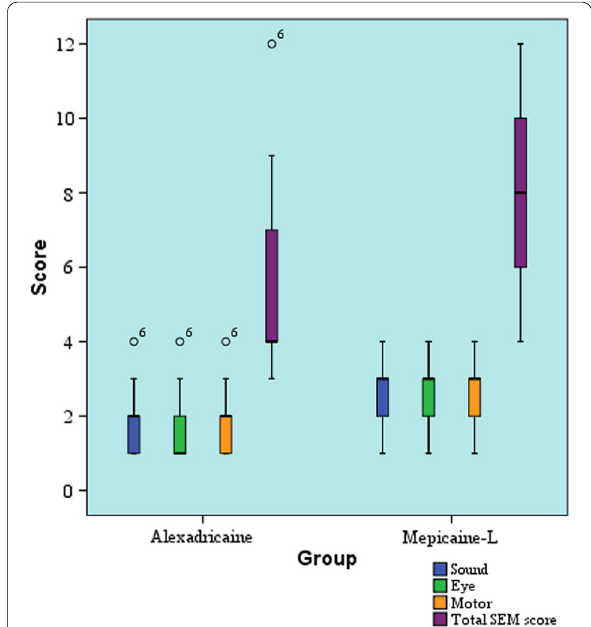
Fig. 5 Box plot representing median and range values for Sound, Eye and Motor Scale scores in the two groups (circles represent